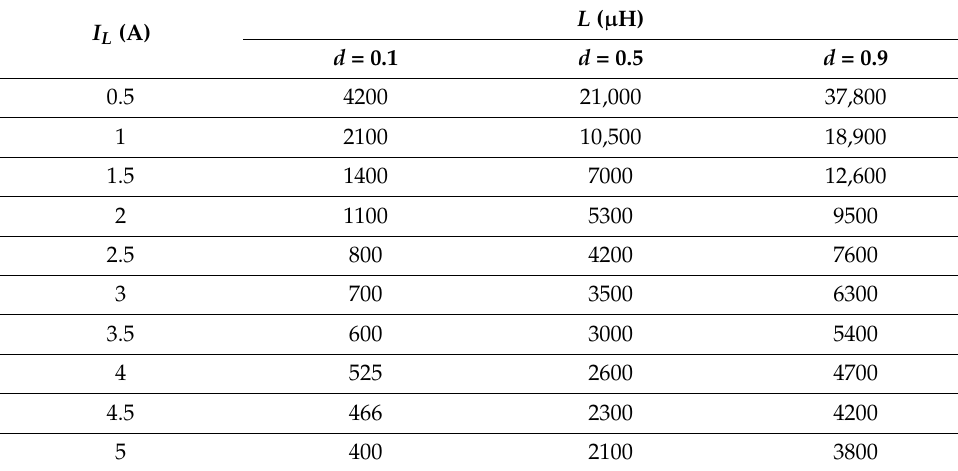
Table 1. Inductor sizing for different current duty cycle values ( f = 20 kHz, V i = 42 V).